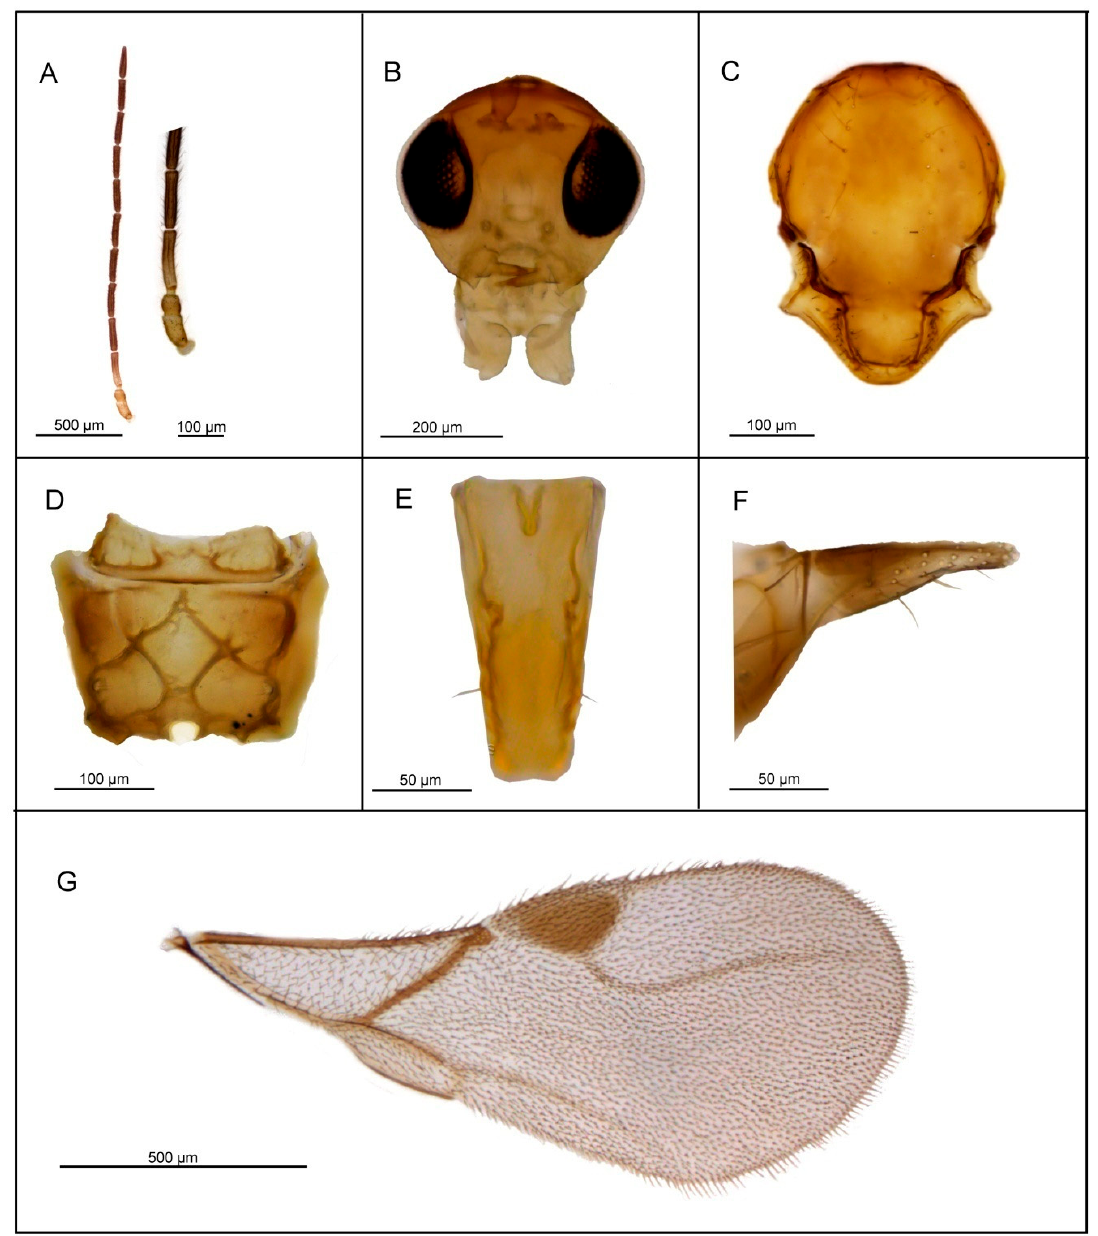
Figure 11. Lipolexis oregmae : ( A ) antenna and F1 – F3; ( B ) head; ( C ) mesoscutum; ( D ) propodeum; ( E ) petiole, dorsal view; ( F ) ovipositor sheath; ( G ) forewing.